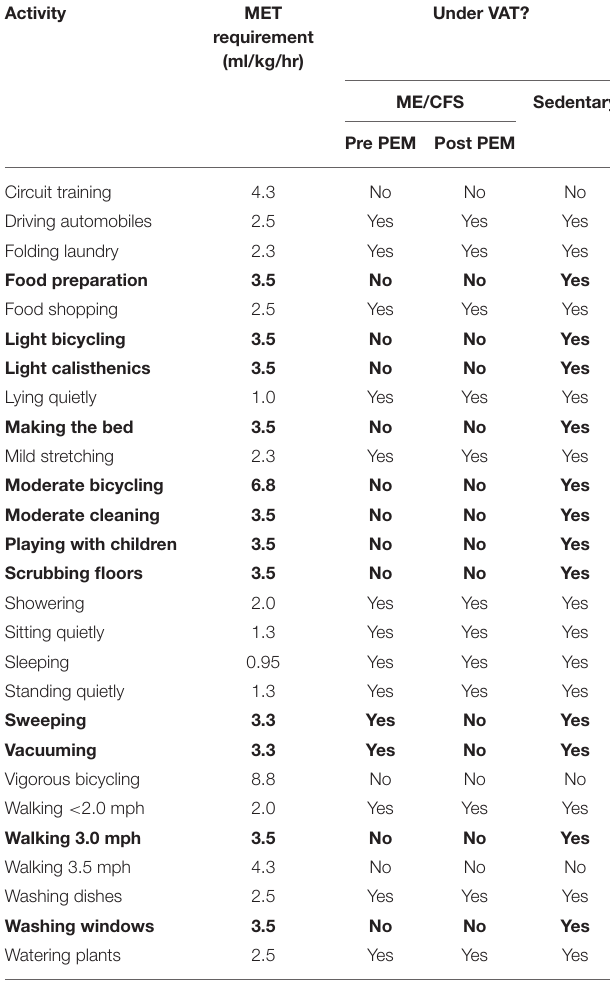
individuals with ME/CFS and sedentary individuals appear in bold. ME/CFS, myalgic encephalomyelitis/chronic fatigue syndrome; METs, metabolic equivalents; PEM, post- exertional malaise; VAT, ventilatory anaerobic